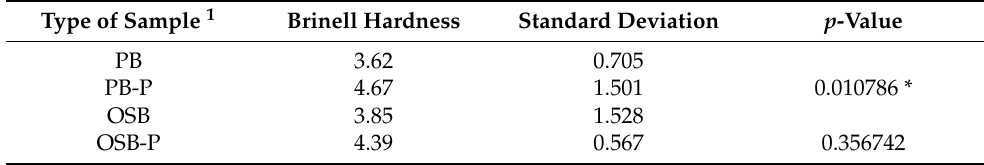
Table 3. Brinell hardness of raw and re-pressed samples.